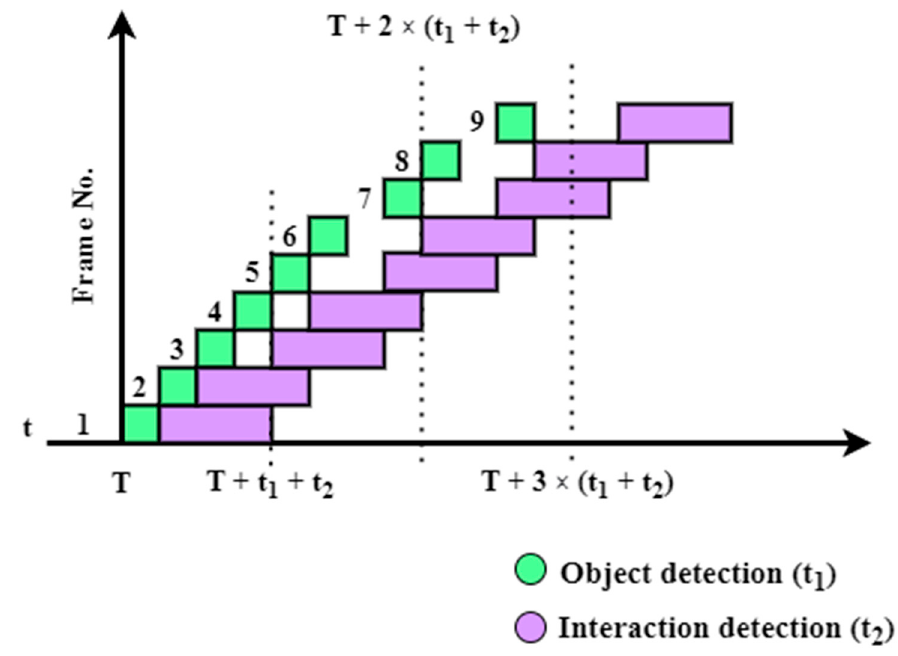
Figure 17. Configuration using two threads.